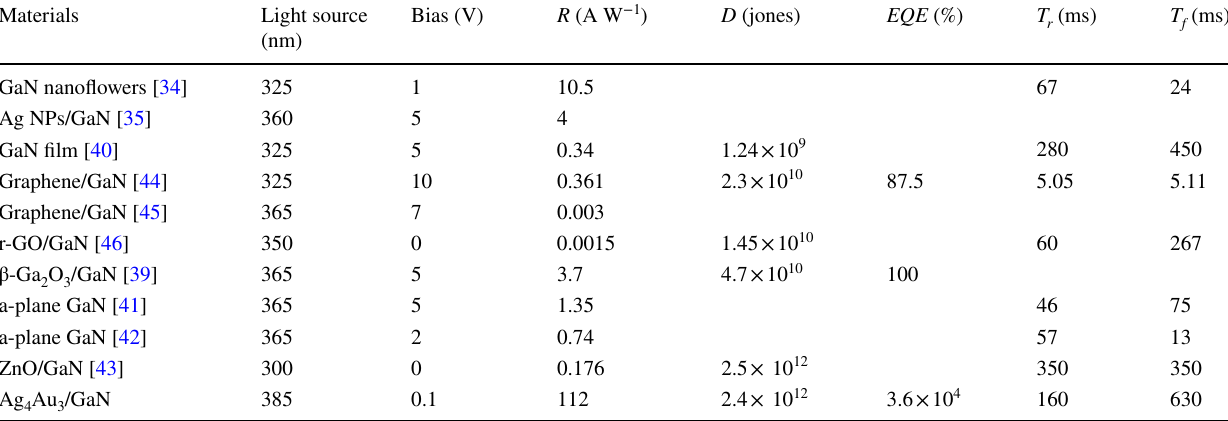
Table 1 Comparision of performance parameters of the GaN‑based UV photodetectors with various device configurations and materials reported in recent years